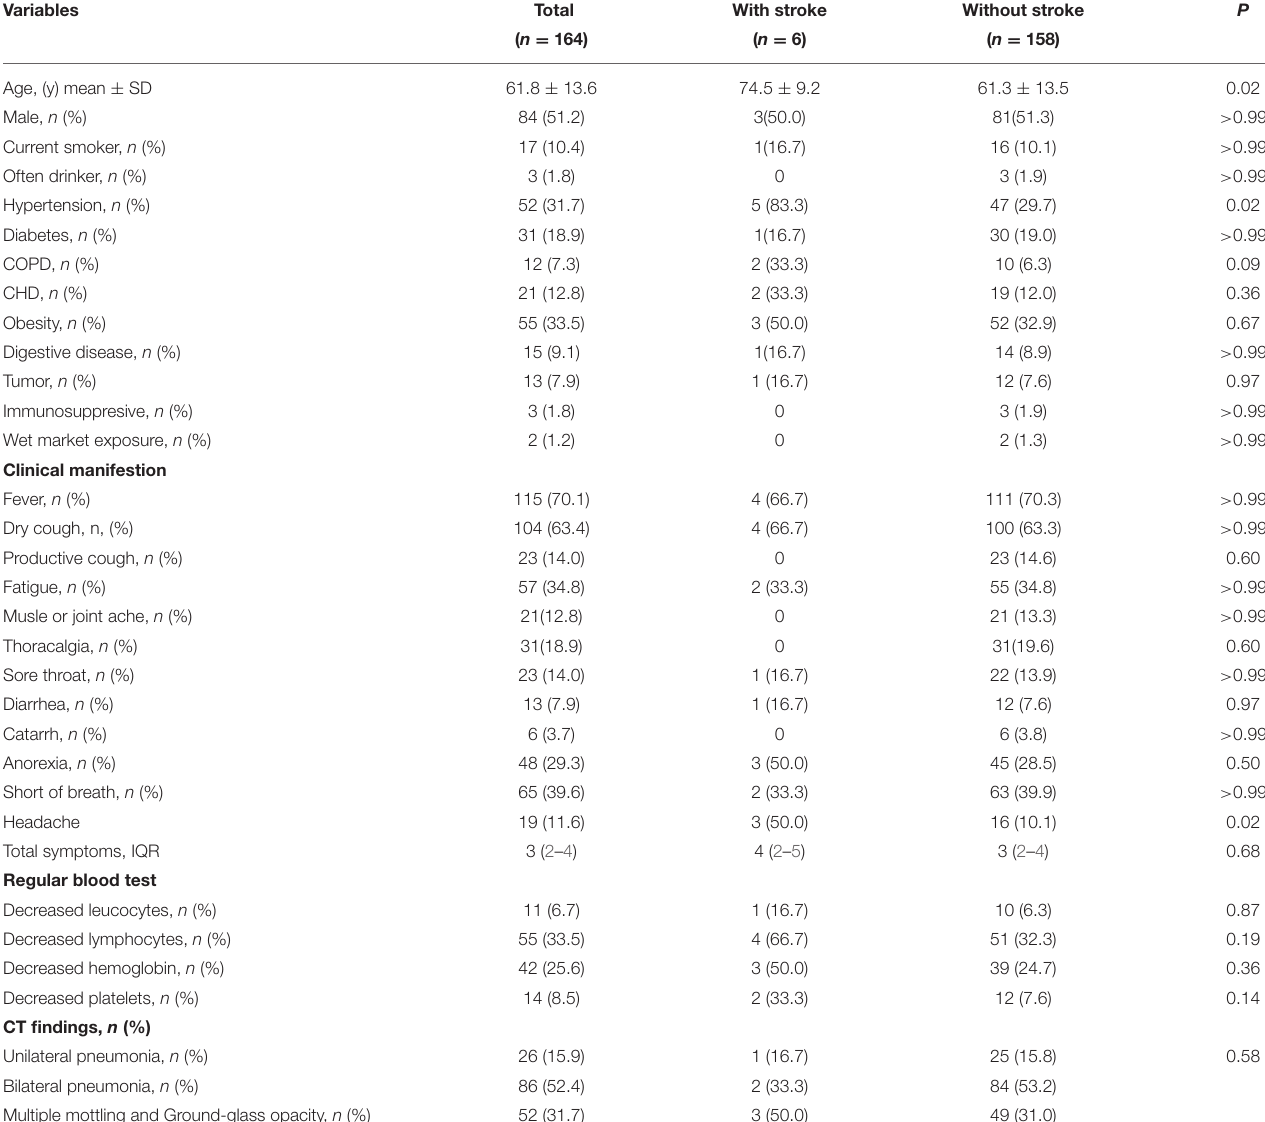
TABLE 1 | Characteristics at baseline in COVID-19 patients with and without previous stroke history.